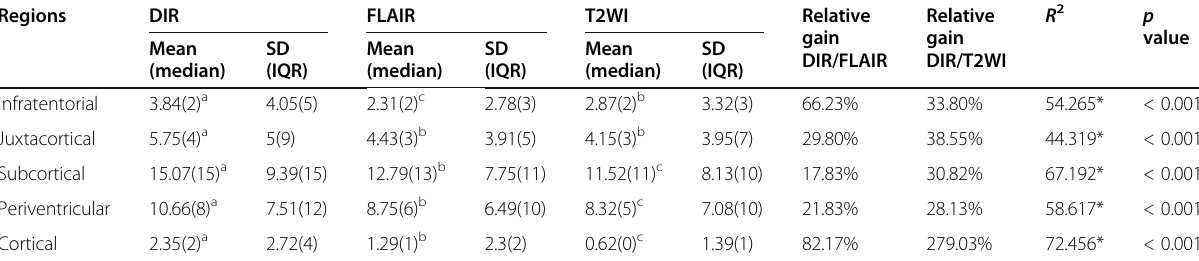
Table 2 Comparison of number of lesions based on regions among DIR, FLAIR and T2WI Regions DIR FLAIR